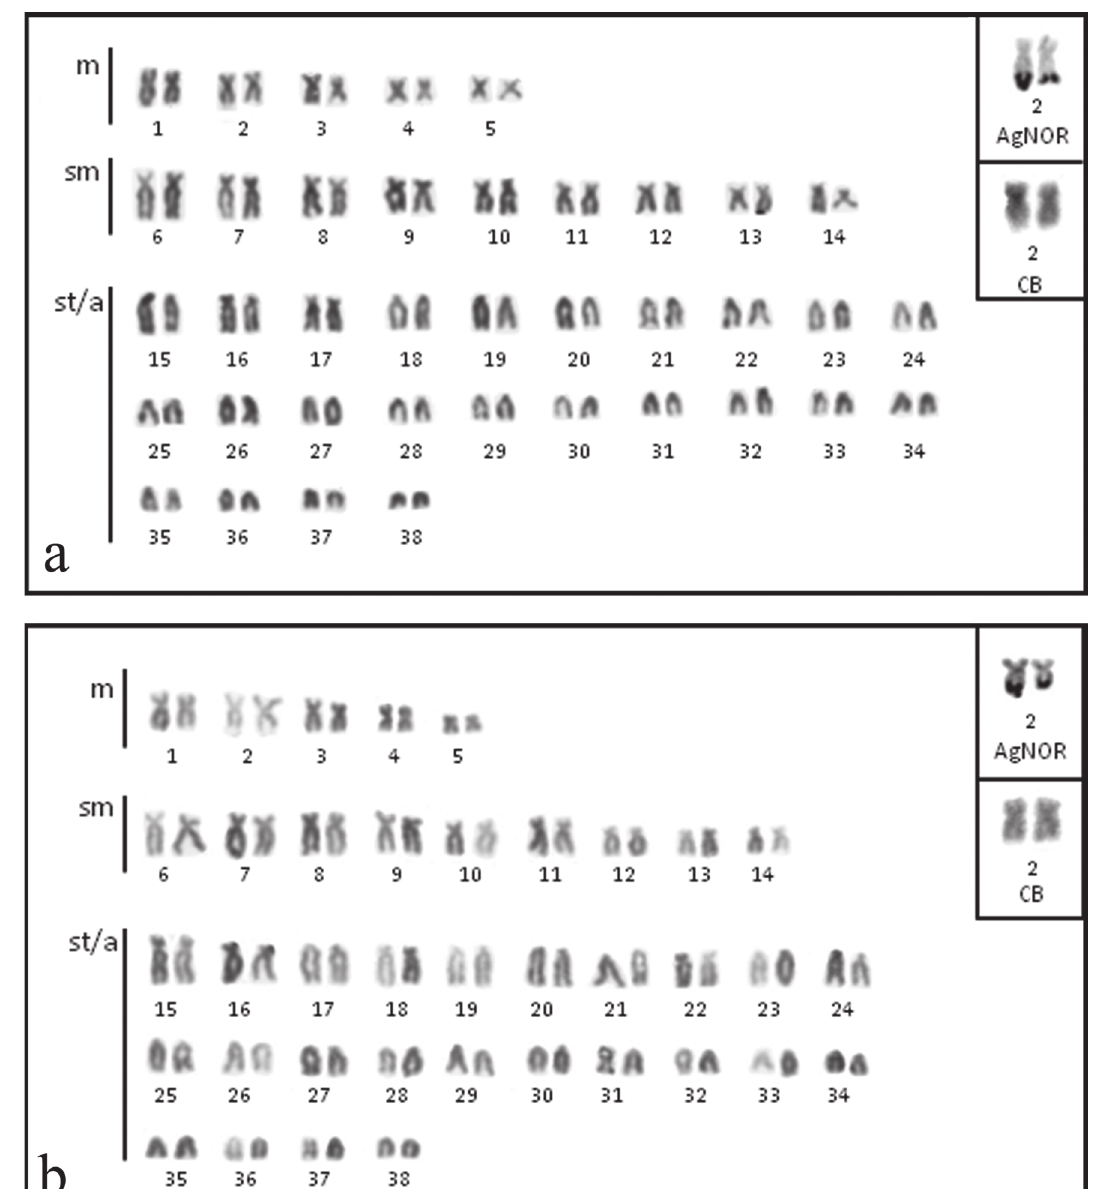
the NOR-bearing pair after silver nitrate (Ag-NOR) and C-banding